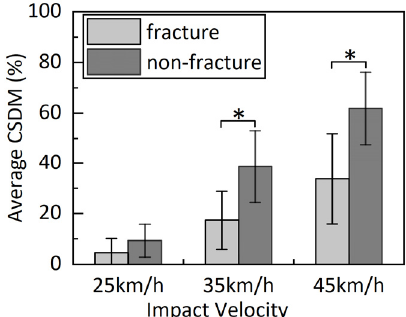
Figure 13. Comparison of cumulative strain damage measure (CSDM) between fracture and non-fracture models (strain threshold of 0.15).